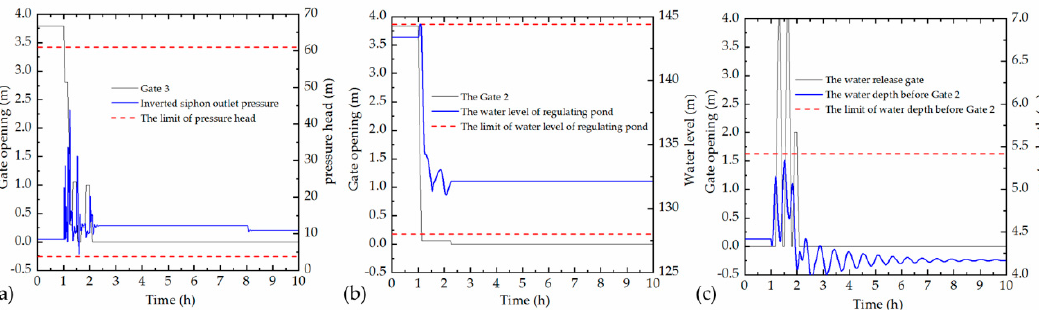
Figure 9. The simulation result of Scenario D with target flow of 0 m 3 / s: ( a – c ) are same with Figure